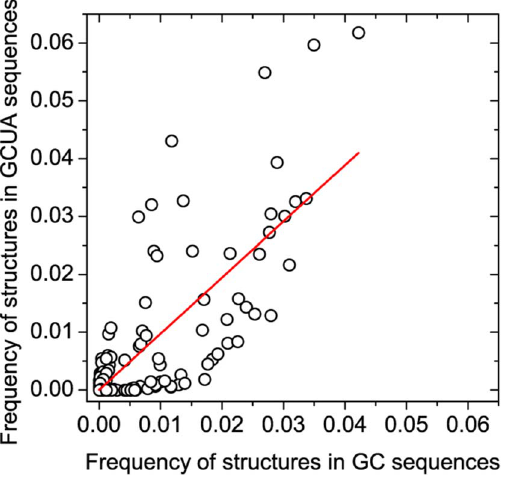
Figure 6. Correlation of structure frequencies of GC (two-letter) and GCAU (four-letter) sequences of length